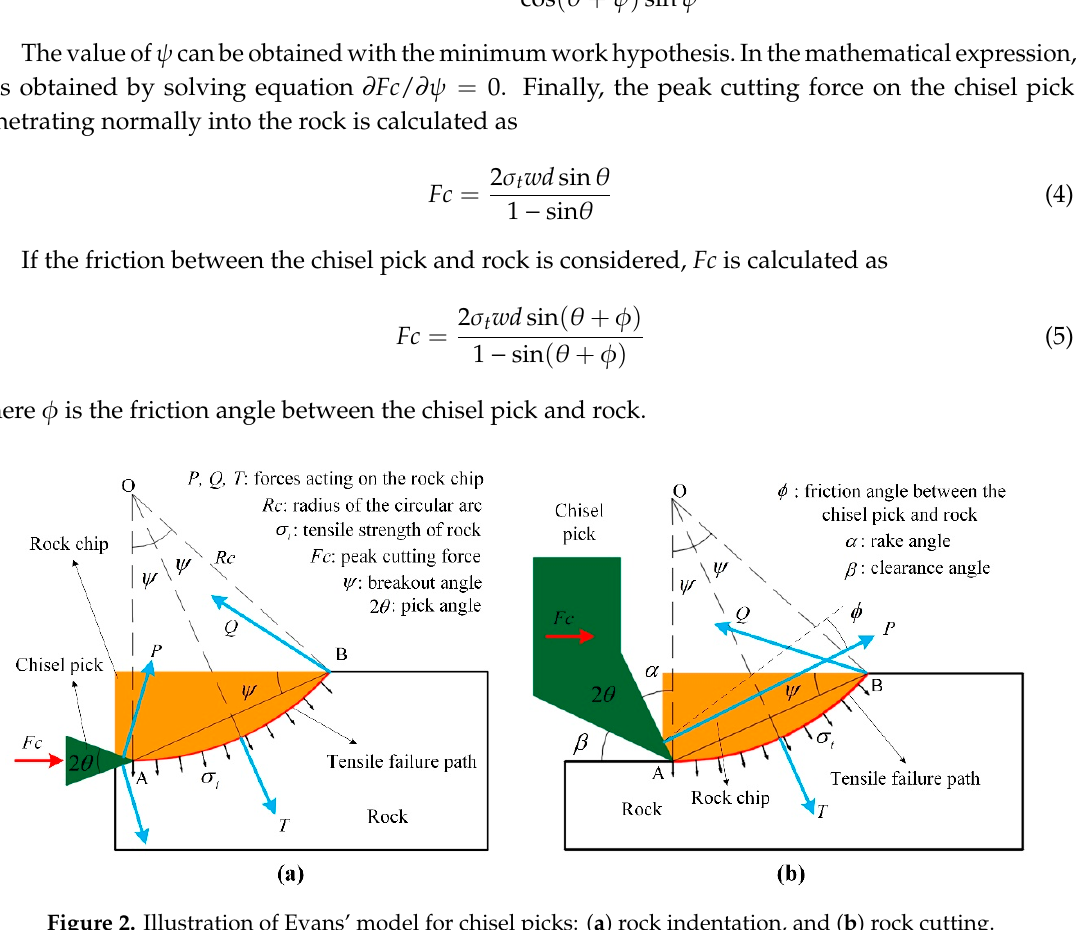
Figure 2. Illustration of Evans’ model for chisel picks: ( a ) rock indentation, and ( b ) rock cutting.